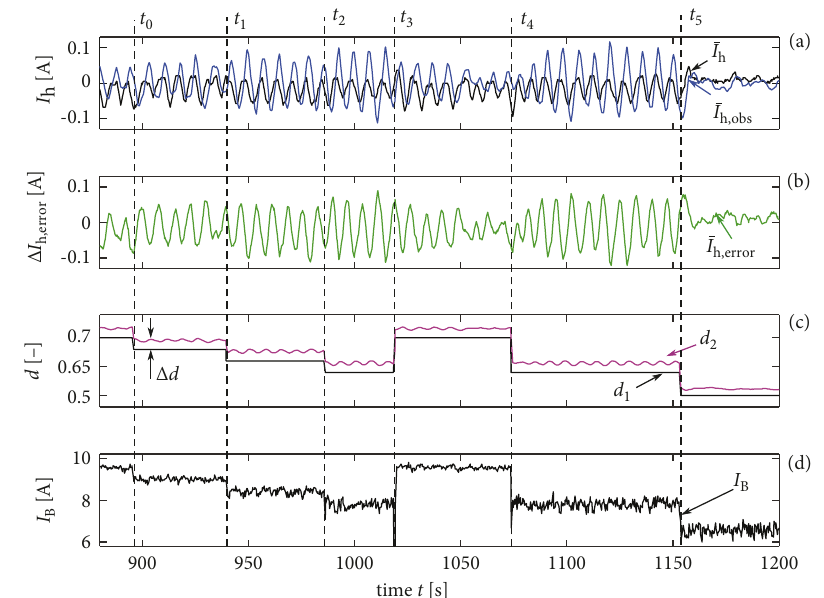
Figure 13: Experimental results of PSFB prototype in different operating points at times t I following the dynamical behavior of real I h , obs In (c) ctr Ih adjusts d due to variation of d 2